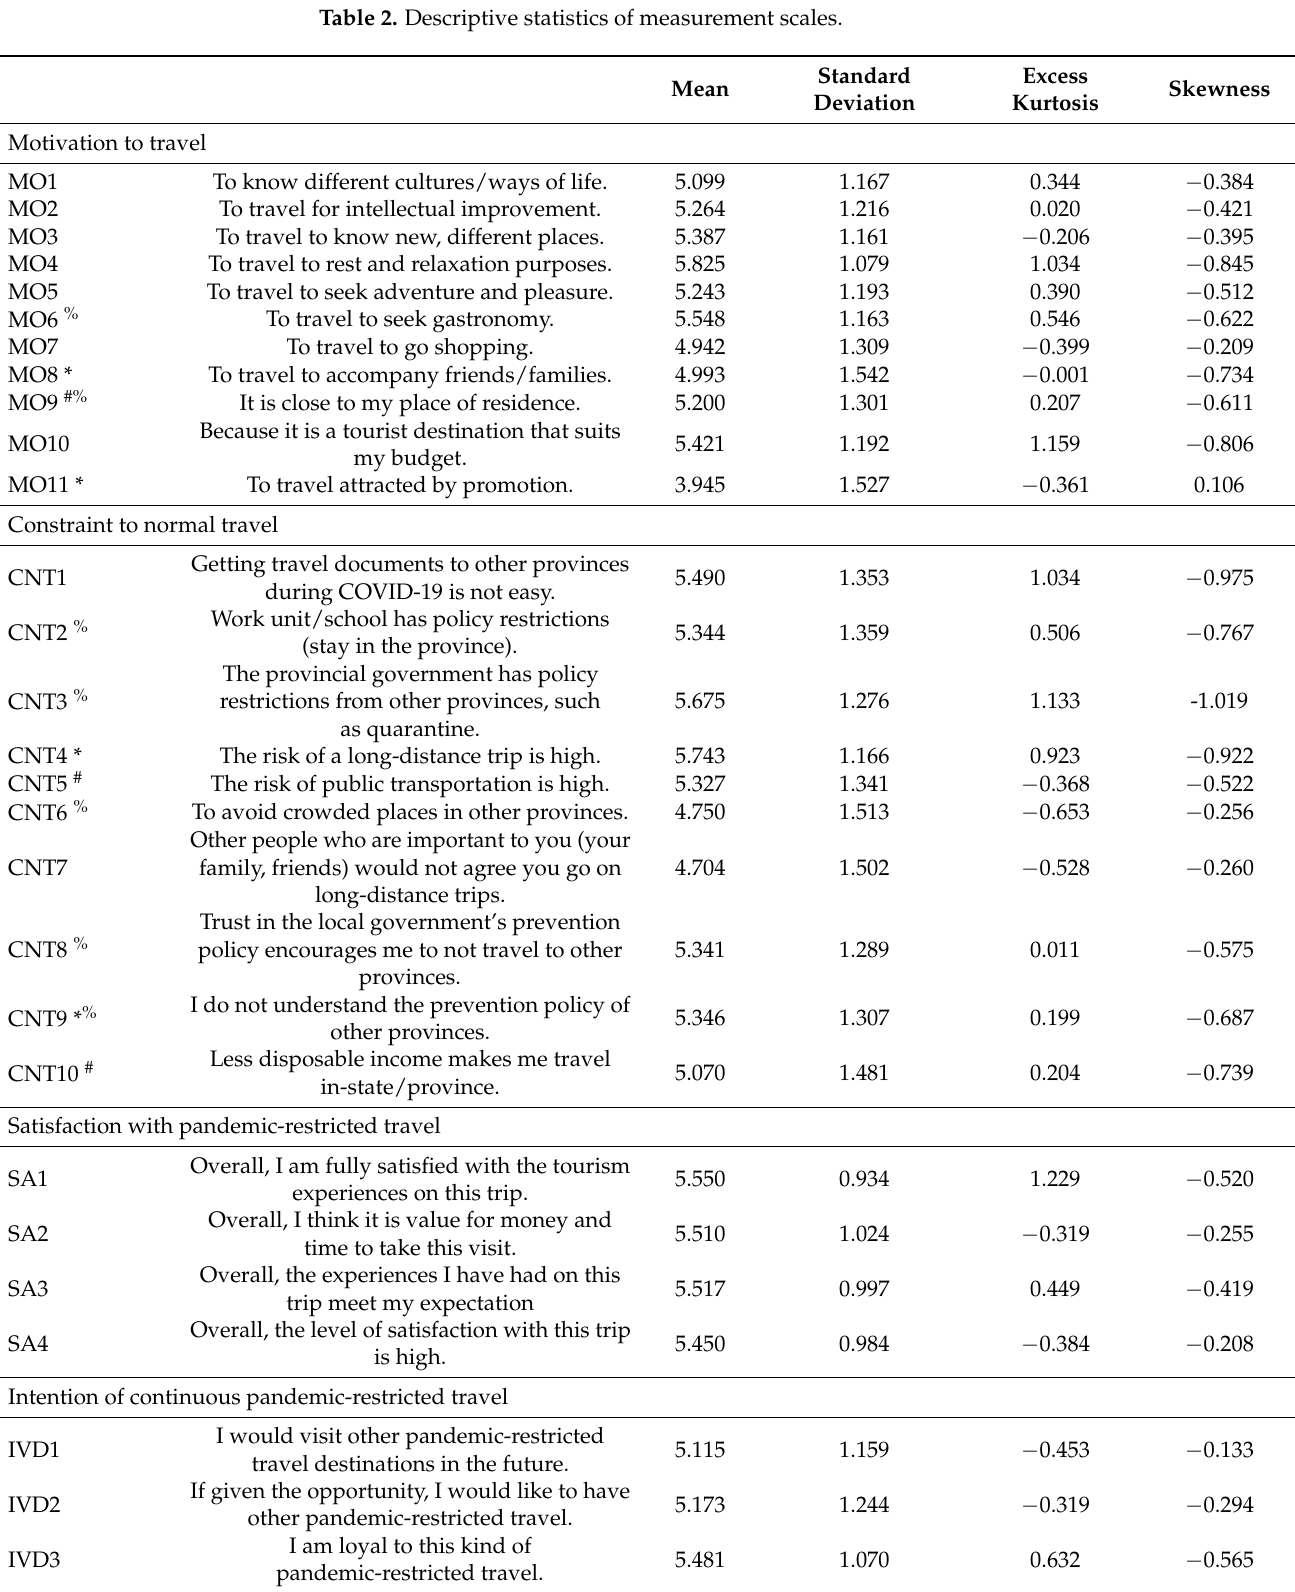
Table 2. Descriptive statistics of measurement